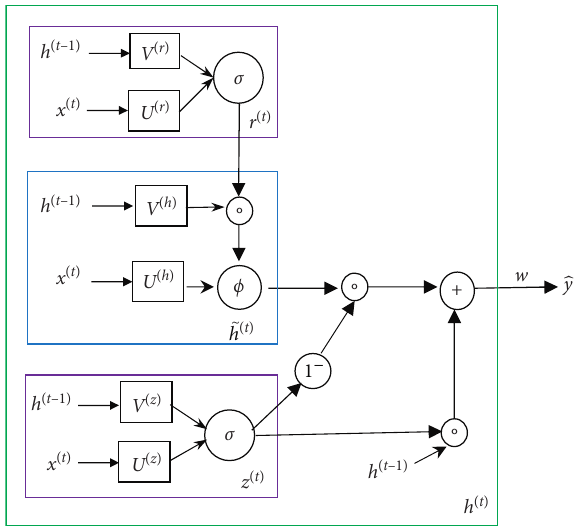
Figure 4: Structure diagram of a GRU node.